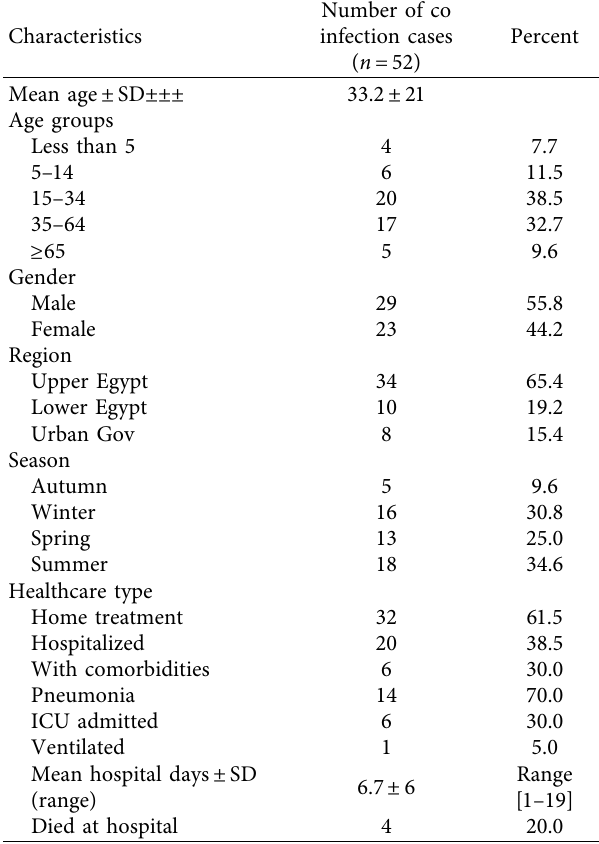
Table 1: Epidemiology, disease severity and outcome of the SARS-CoV-2 and infuenza co-infection, Egypt integrated acute respiratory surveillance,